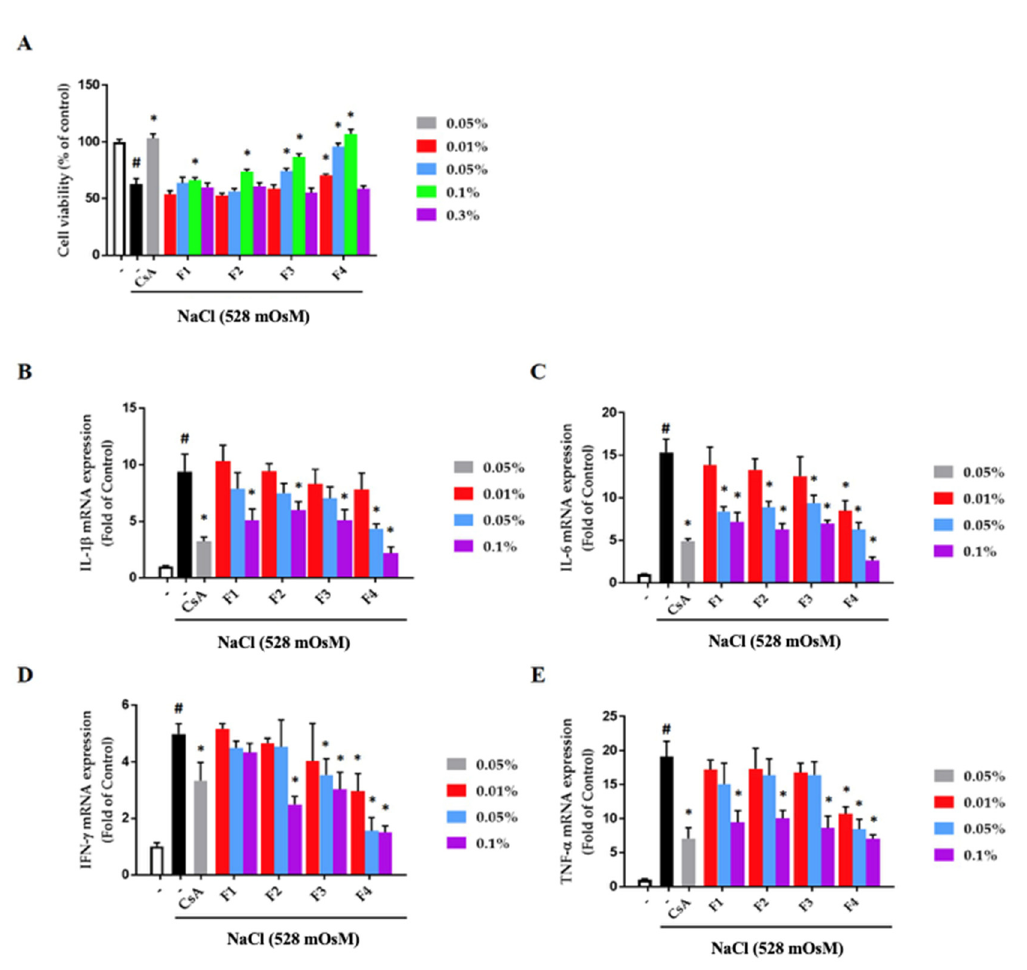
Figure 6. E ff ect of formulations on hyperosmolar stress-stimulated inflammation in human conjunctival epithelial cells. ( A ) The cells were co-treated with each formulation and hyperosmolar cell media (528 mOsM) for 24 h ( n = 4). mRNA expression of IL-1 β ( B ), IL-6 ( C ), IFN- γ ( D ), and TNF- α ( E ) was examined by quantitative real-time PCR assay. Cyclosporine A (CsA) was used as a positive control. Glyceraldehyde 3-phosphate dehydrogenase (GAPDH) was regarded as an internal control ( n = 3). # p < 0.05, significantly di ff erent from the untreated group; * p < 0.05, significantly di ff erent from the hyperosmotic-treated group.